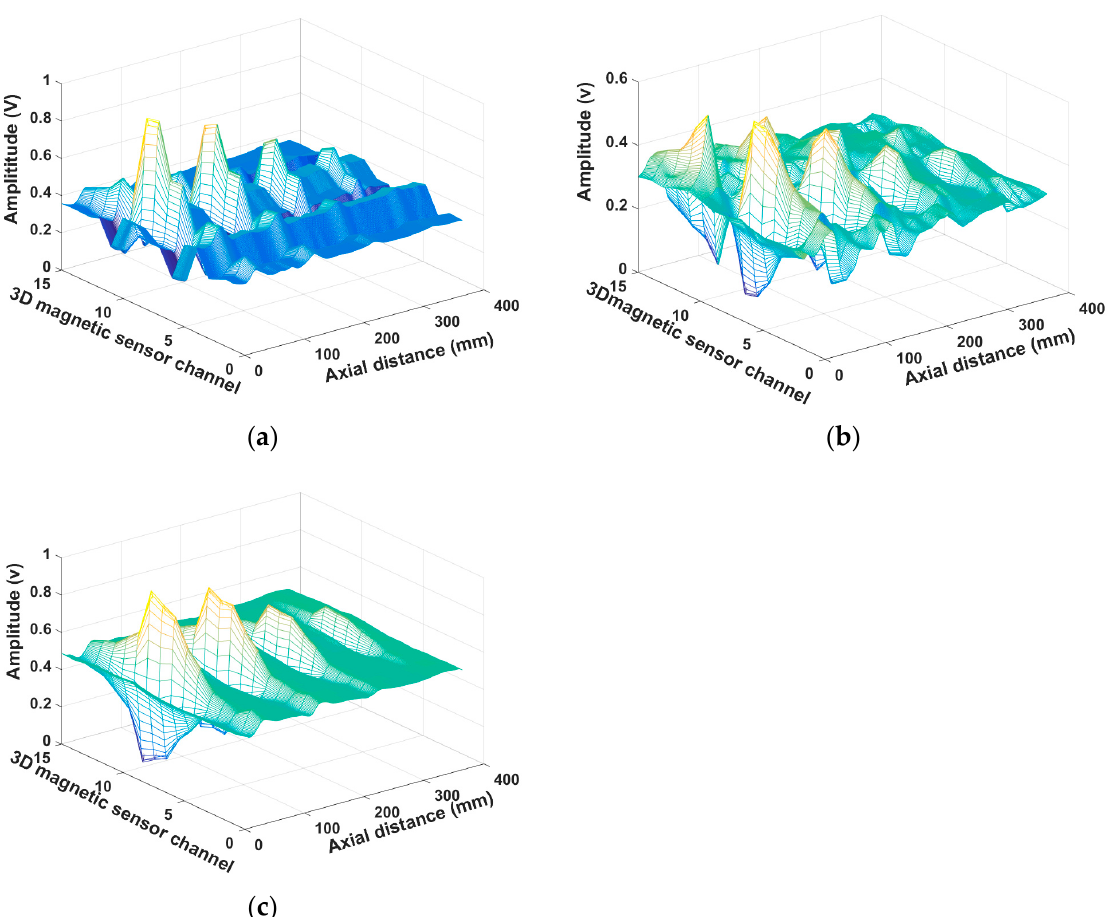
Figure 6. 3D MFL signals of 15 channels after noise reduction. ( a ) x axis after noise reduction; ( b ) y axis after noise reduction; ( c ) z axis after noise reduction.